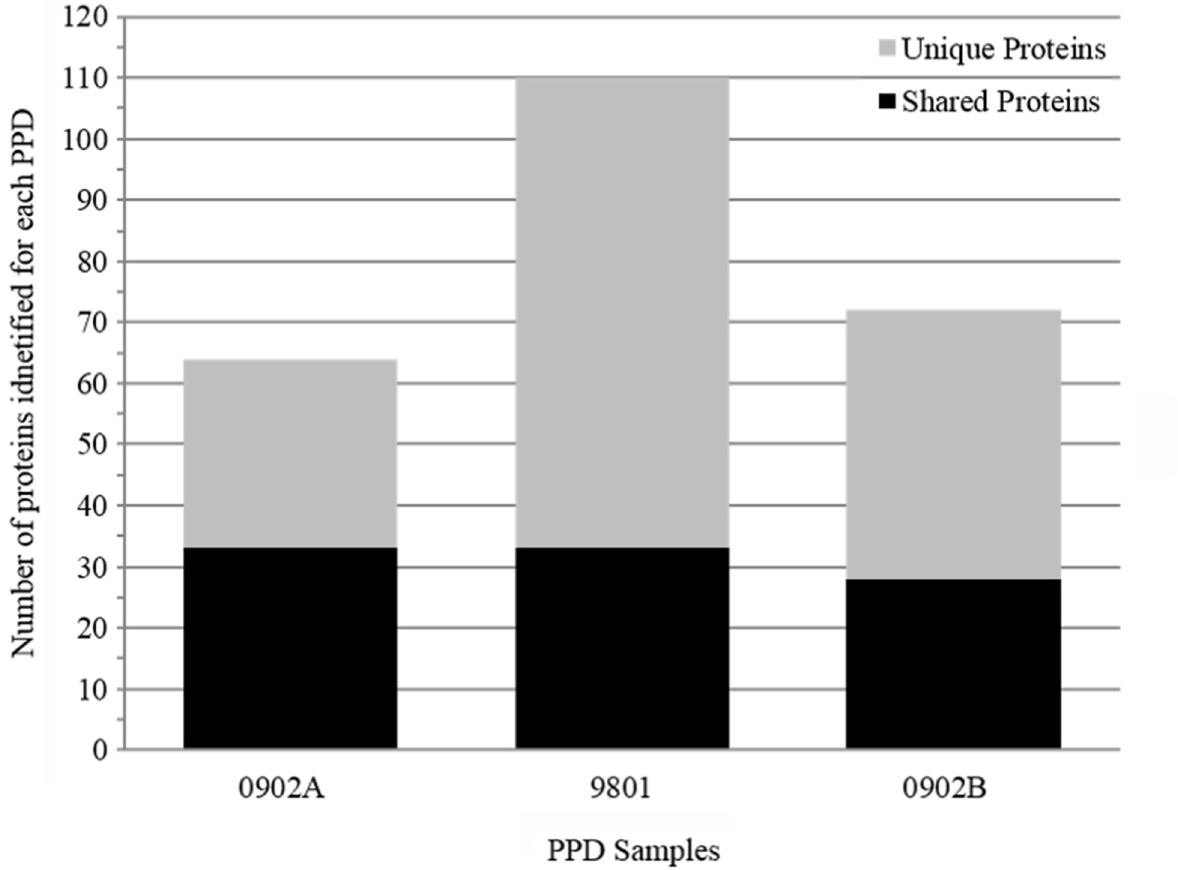
Fig 3. Number of proteins identified by LC-MS/MS for each PPD preparation analyzed. Proteins found in two or three PPD preparations are indicated by the black bars and proteins unique to each individual PPD preparation are indicated by the grey bars.